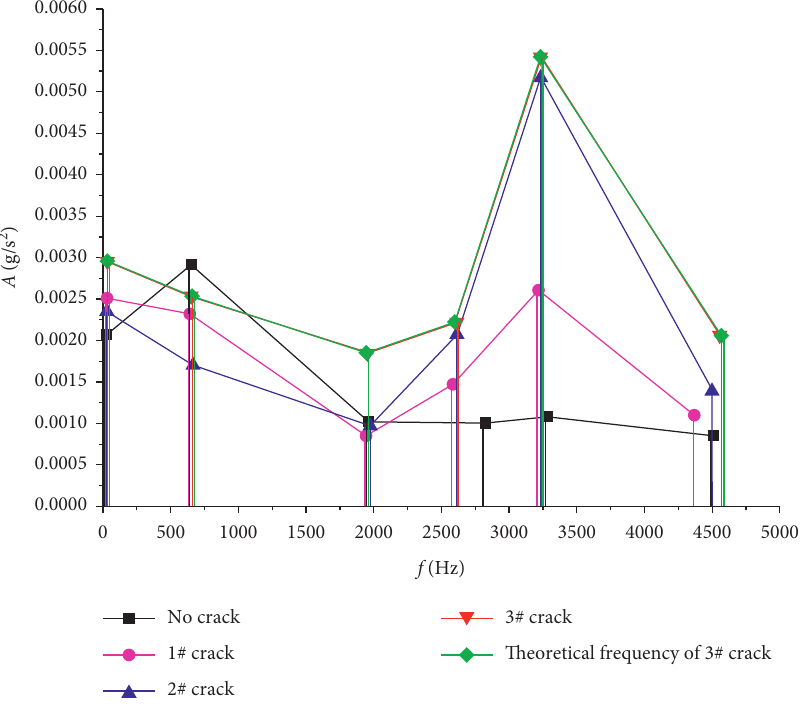
Figure 17: Central frequency and amplitude of each IMF. Table 9: Error between the tested IMF central frequency and theoretical value for 3 # crack.